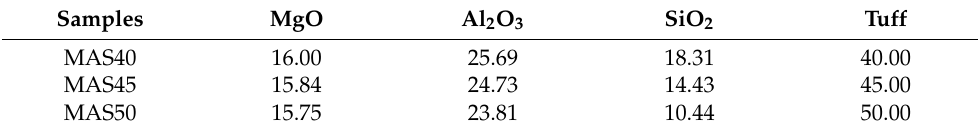
Table 2. The weight percentages (wt.%) of initial raw materials in the basic